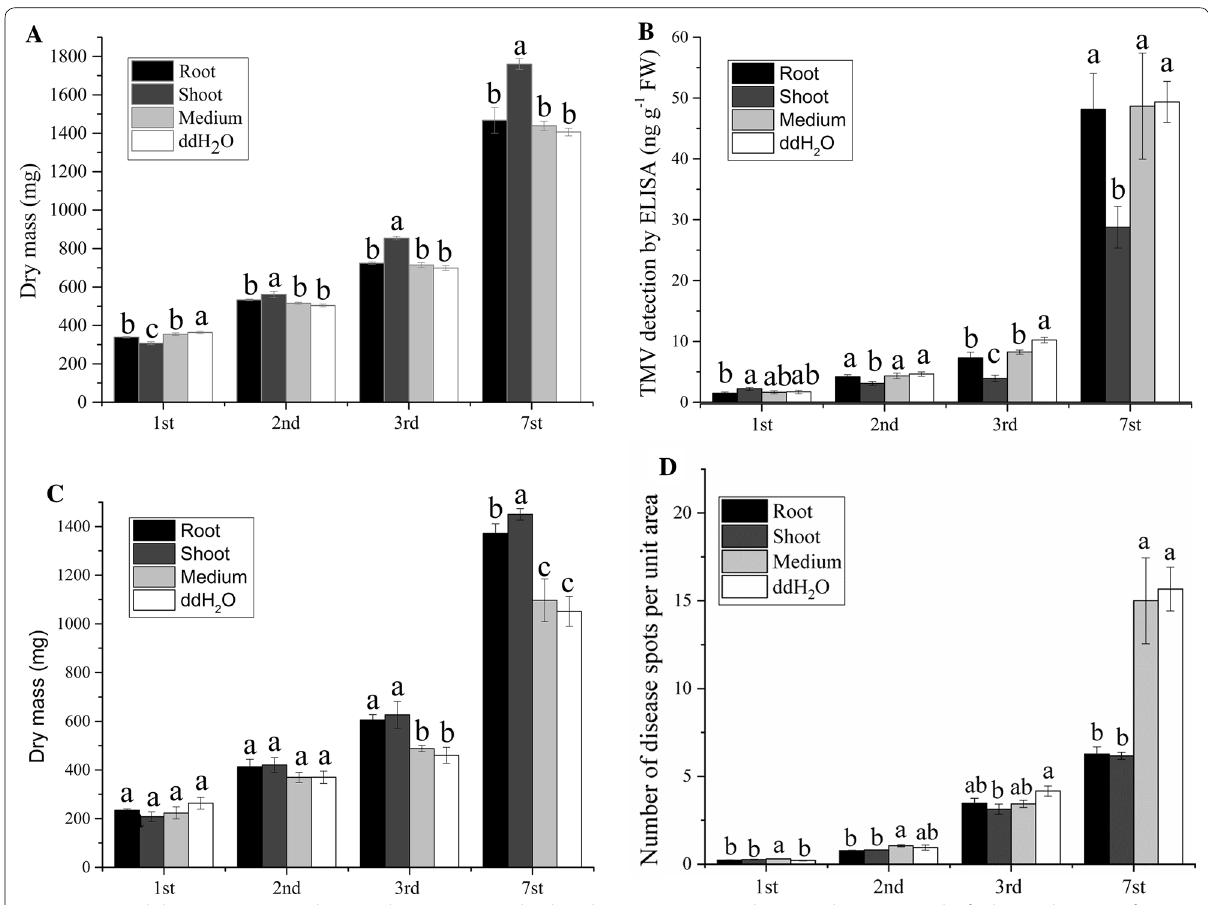
Fig. 6 Root and shoot treatment to the growth promotion and Induced resistance test in tobacco and rice. A 1 week of tobacco dry mass of four treatments were calculated after 1st, 2nd, 3rd and 7th days after treated. All treatments were repeated 3 times. B Determination of TMV accumulation in tobacco by ELISA. The tobacco were pre-treated with the indicated treatment before TMV inoculation. The TMV accumulation was determined by ELISA, and 12 leaf samples were obtained for each treatment. C 1 week of rice dry mass of four treatments were calculated after 1st, 2nd, 3rd and 7th days after treated. All treatments were repeated 3 times. D Lesion density was performed by counting lesion numbers of unit area. Different letters indicate significantly differences using Fisher’s LSD (P =